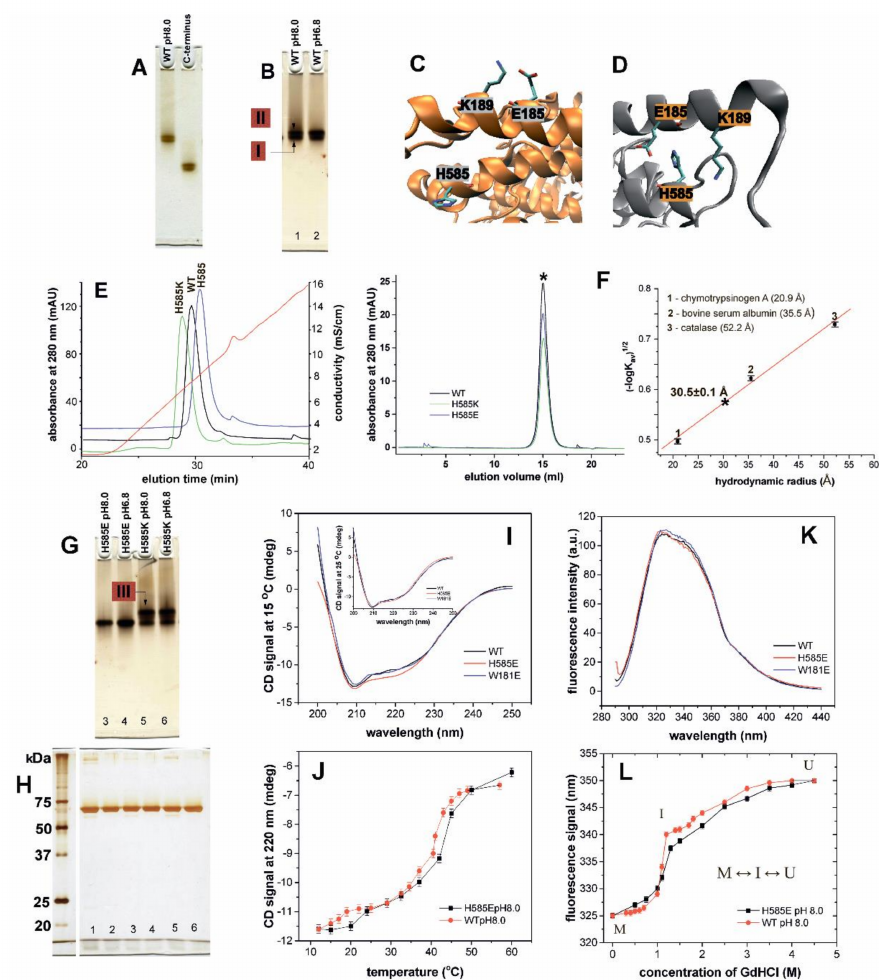
Figure 2. Structural characterization of wild-type and mutant rabbit ALOX15. ( A ) Native PAGE electrophoresis of rabbit ALOX15 and its catalytic domain. ( B ) Effect of pH on structural heterogeneity of ALOX15. At pH 8.0 the two conformers (red labelled enzyme pools I and II) are better resolved when compared with pH 6.8. ( C ) Crystal structure of conformer A (no ligand at the active site). In this structure the side chain of His585 (H585) is localized on the protein surface and is accessible to the solvent. ( D ) Crystal structure of conformer B (ligand bound at the active site). Here the side chain of His585 (H585) is buried inside the protein between the side chains of Glu185 (E585) and Lys189 (K189). It is shielded from the solvent. ( E ) Elution order of the purified ALOX15 variants from the Resource Q (6 mL) column in anion exchange chromatography using a linear NaCl gradient. Absorbance of the column effluent at 280 nm (green, black, blue) and conductivity (red curve) were simultaneously recorded. ( F ) Size exclusion chromatography (left panel) of the purified recombinant proteins was carried in 20 mM Tris-HCl buffer and we estimated their hydrodynamic radii using different calibration proteins (right panel). The elution volume of the wild-type ALOX15 and the mutants is labelled with asterisk. ( G ) Native PAGE of rabbit ALOX15 mutants was performed at two different pH as described above for the wild-type ALOX15. ( H ) SDS-PAGE of the enzyme preparations (the numbers correspond to the protein samples that are present on panels B and G). ( I ) CD spectra of wild-type and mutant rabbit ALOX15. ( J ) Thermal stability of wild-type rabbit ALOX15 and its His585Glu (H585E) mutant. The relative intensity of the CD signal of ALOX solution was measured at 220 nm at different temperatures. ( K ) Fluorescence spectra of wild-type and mutant rabbit ALOX15. ( L ) The shift of the maximum of the fluorescence spectrum in the presence of different concentrations of GdnHCl was monitored by fluorescence steady state spectroscopy for wild-type rabbit ALOX15 and its His585Glu (H585E) mutant. The GdnHCl denaturation curves follow a 3-state transition model (ground state M ↔ intermediate sate I ↔ unfolded state